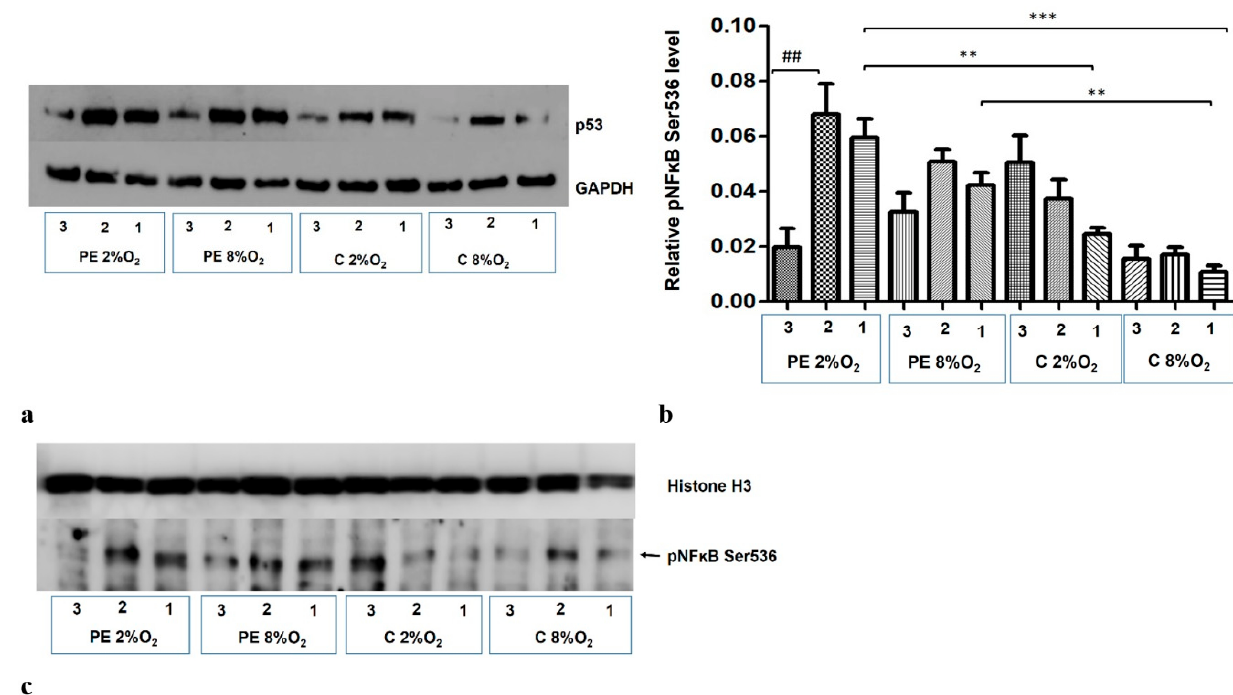
Figure 6. Western blot results. ( a ) inhibition of p53 by its targeted siRNA; Western blot results for the cytoplasmic fraction, ( b ) the differences in relative level of pNFkB Ser536 to Histone H3 in nucleus of HTR8/SVneo cells. Cells were cultured for 96 h in hypoxic or normoxic conditions with medium containing 1% serum from preeclamptic or normotensive women. For the first 48 h, the cells were incubated only with medium containing the maternal serum. After 48 h and 72 h, the cell medium was supplemented with the following factors: none i.e., cells without siRNA (1), non-targeting siRNA (2) and targeted siRNA against mRNA coding for p53 (3). The relative level of pNFkB Ser536 to Histone H3 in the nucleus was analyzed. Values are presented as mean ± SEM; ( n = 3experiments). The difference in pNFkB Ser536 level between cells stimulated by negative and targeted siRNA was calculated by the Student’s t -test; ## p < 0.01. The difference in pNFkB Ser536 level between the four culture types (i.e., oxygen tension and serum type) which were not stimulated with siRNA were analyzed by ANOVA with the Bonferroni post hoc test; ** p < 0.01, *** p < 0.001. ( c ) Western blot results for nuclear fraction containing pNFkB Ser536 and Histone H3, as a loading control.